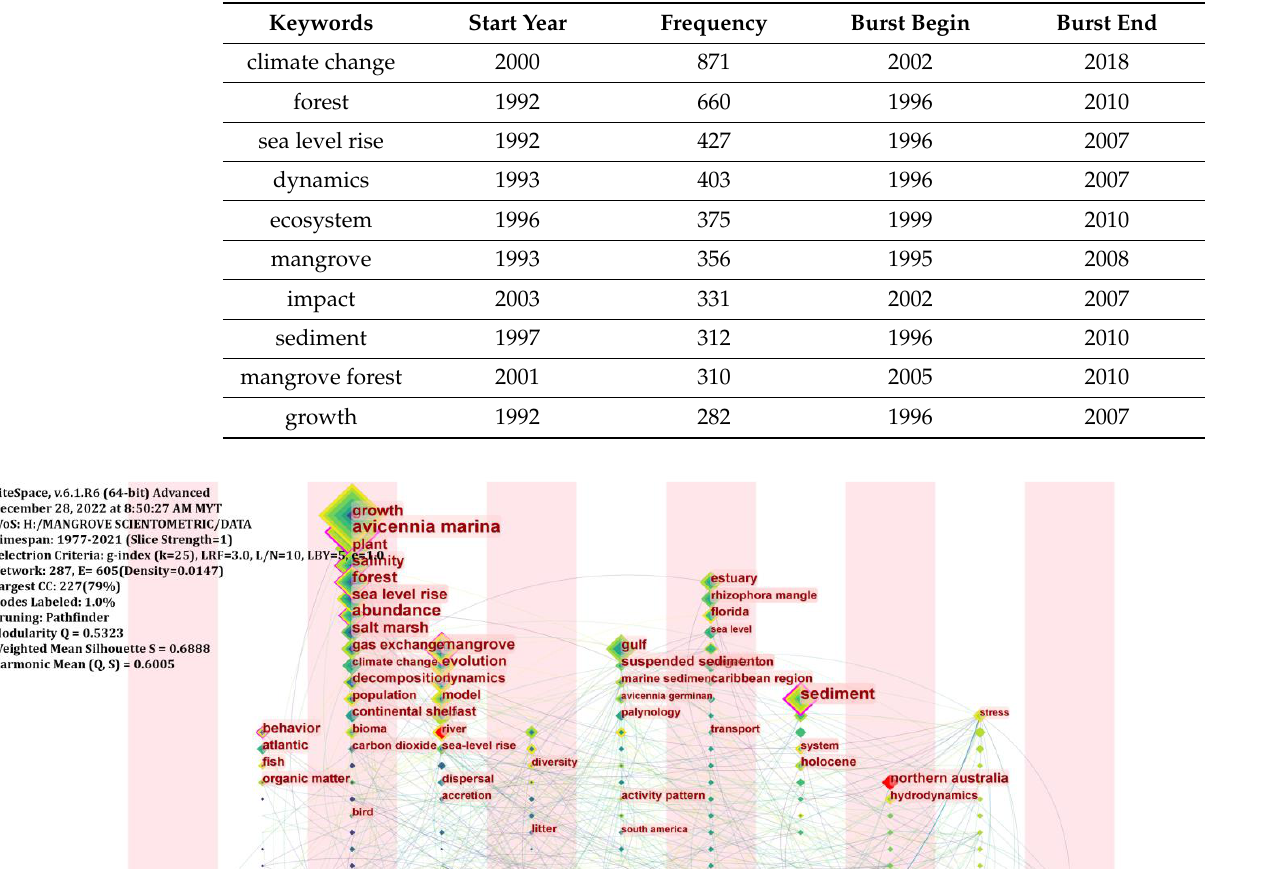
Table 9. Top 10 frequently used keywords for mangrove and climate change publications (1977–2021).